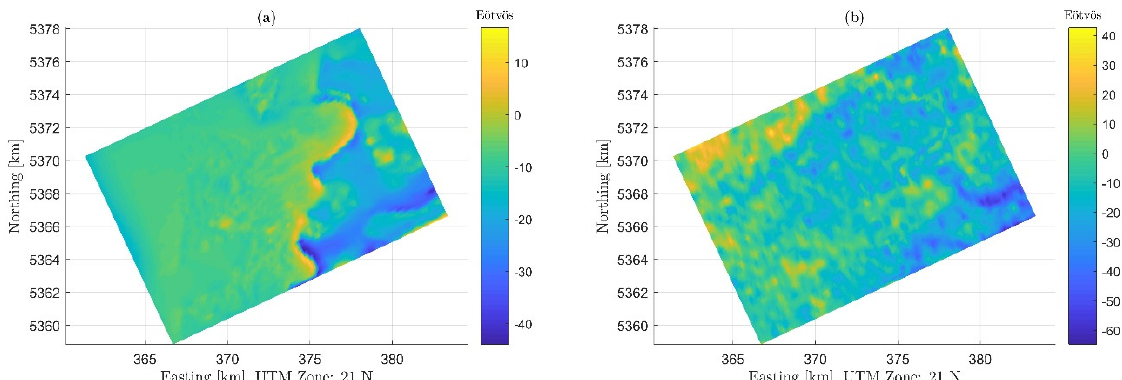
Figure 4. ( a ) Terrain effects, namely the vertical-vertical gravity gradients due to seafloor topography; ( b ) Non-terrain effects, namely the difference between the measured gravity gradients shown in the black dashed-rectangle in Figure 3a and the terrain effects shown in Figure 4a.